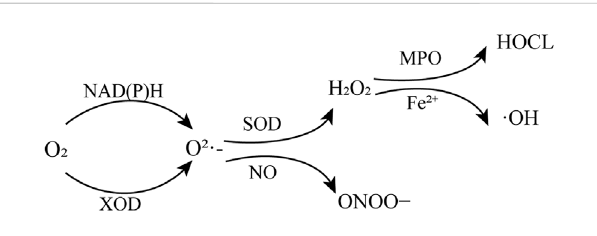
FIGURE 1 Production of reactive oxygen species. NAD(P)H, nicotinamide adenine dinucleotide and nicotinamide adenine dinucleotide phosphate; XOD, oxidase and xanthine oxidase; SOD, superoxide dismutase; MPO,